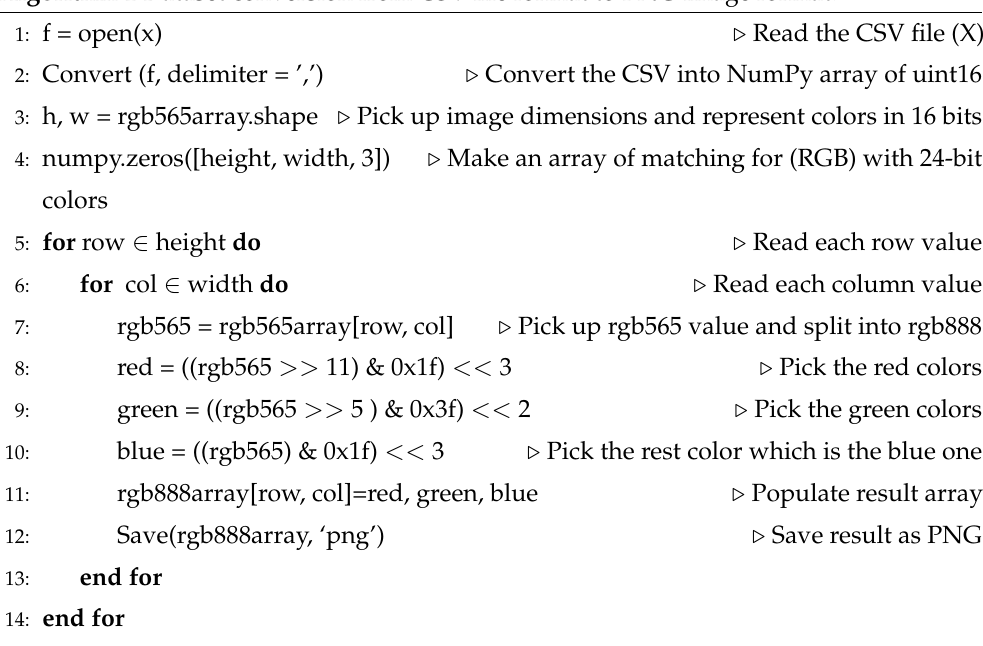
Algorithm 1 Dataset conversion from CSV file format to PNG image format.